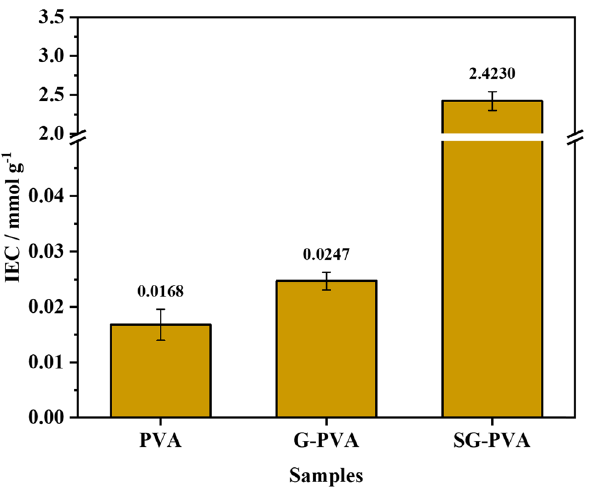
Figure 6: The SAC as a function of desalination time for all PVA